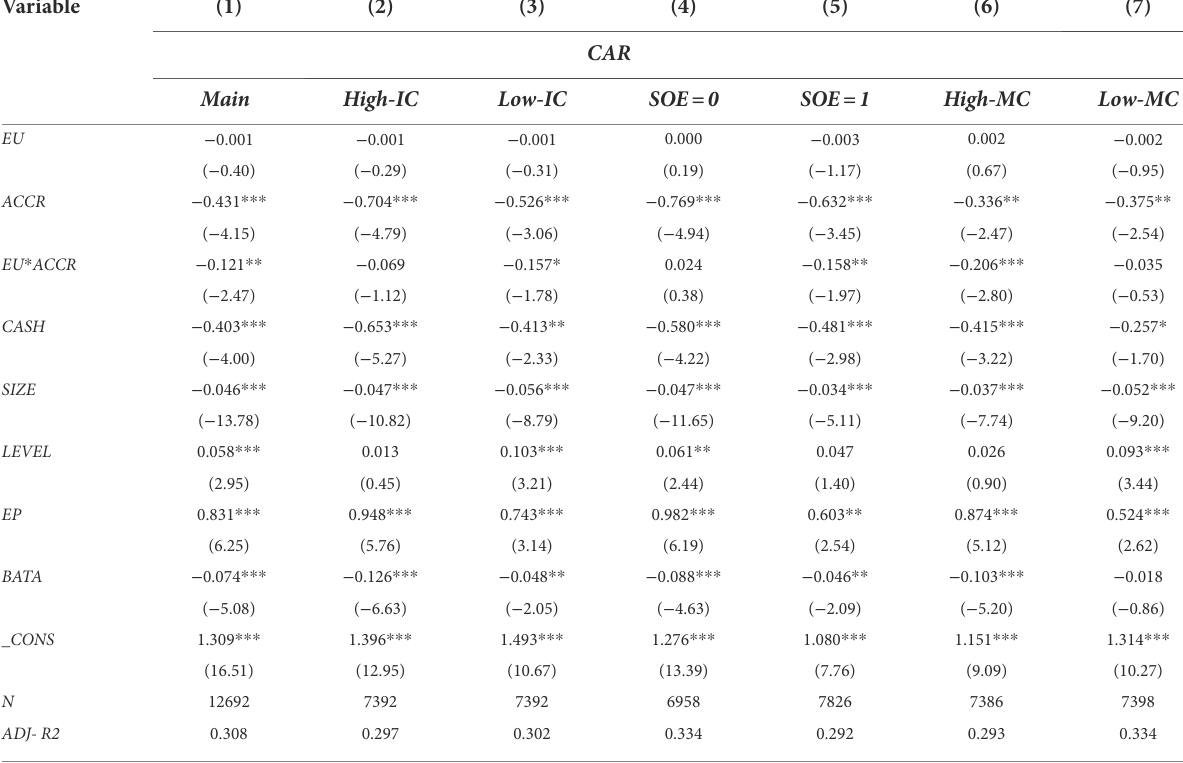
TABLE 10 Robustness test: Eliminating the abnormal samples.